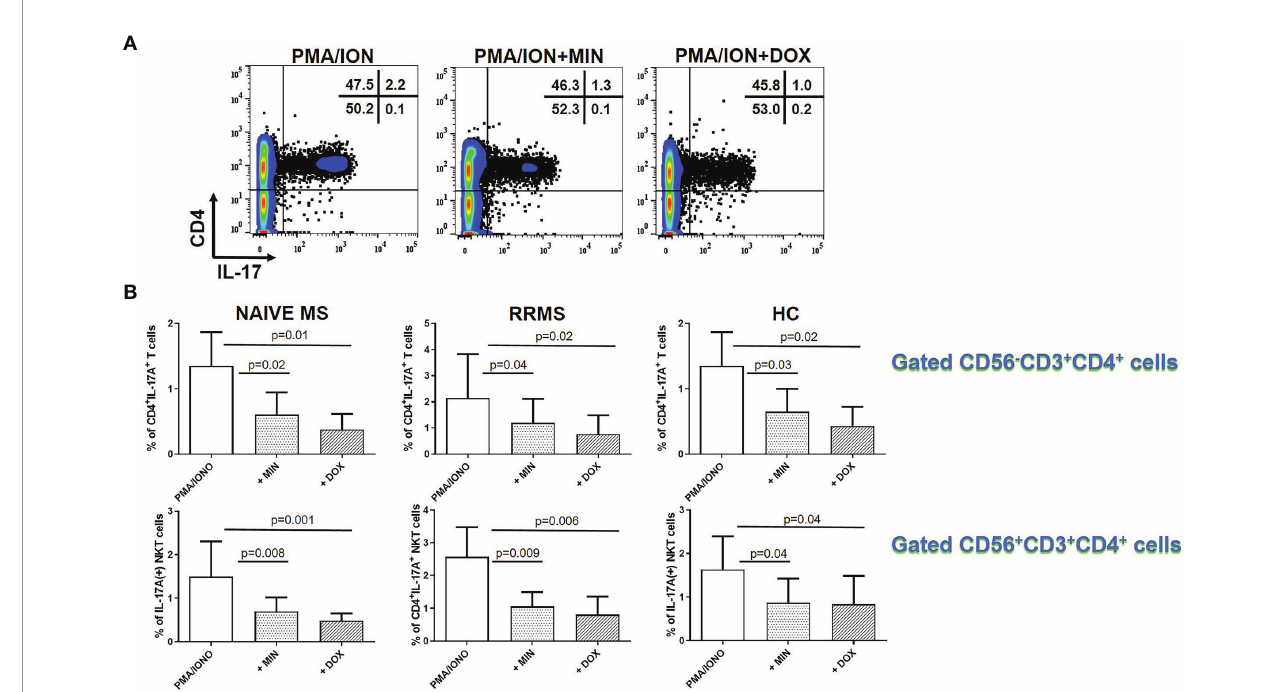
FIGURE 5 | Tetracycline-mediated inhibition of CD4 + CD3 + IL-17A + T cells and CD56 + CD4 + IL-17A + T (NKT) cells. PBMCs from naïve MS patients (n=9), RRMS patients (n=9) and HCs (n=9) were seeded in cell culture plates (1 x 10 6 per well) and stimulated with PMA plus ionomycin (PMA/ION), PMA/ION plus minocycline (MIN) and PMA/ION plus doxycycline (DOX) for 5h. Cells were collected, washed, surface stained with appropriate monoclonal antibodies an analyzed for intracellular IL-17A production by fl ow cytometry (see also methods section). (A) Flow cytometry dot-plots showing the frequency of total CD4 + IL-17A + cells in PMA/IONO, PMA/ IONO/MIN and PMA/IONO/DOX treated cells from a representative naïve MS case. (B) CD4 + IL-17A + cells were sub-divided according to expression of CD3 or CD56 surface epitopes. Box and whiskers graphical representation showing signi fi cant reduction in the percentages of IL-17A-producing T and NKT cells in the presence of tetracyclines in naïve MS patients, RRMS patients and